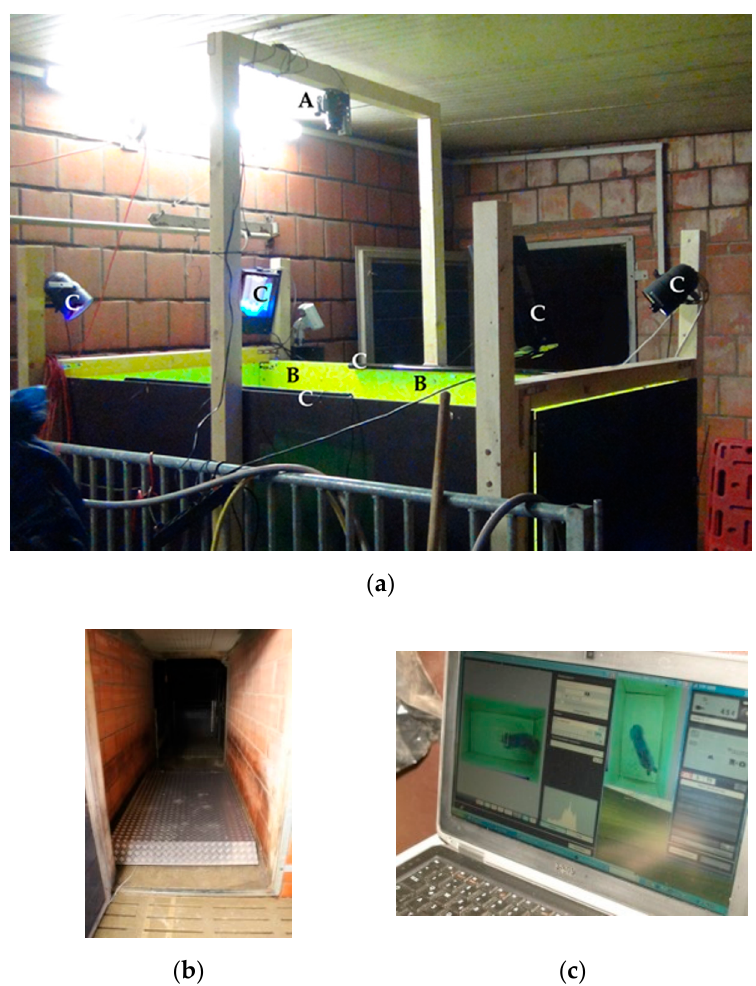
Figure 1. Experimental setup: ( a ) Planimetry box with (A) the centrally fixed camera, (B) fluorescent painted floor and side plates and (C) the UV light sources (exemplary shown), ( b ) the beam balance in a corridor and ( c ) the computerized camera control; the detailed description in Arndt et al. 2019 [41].